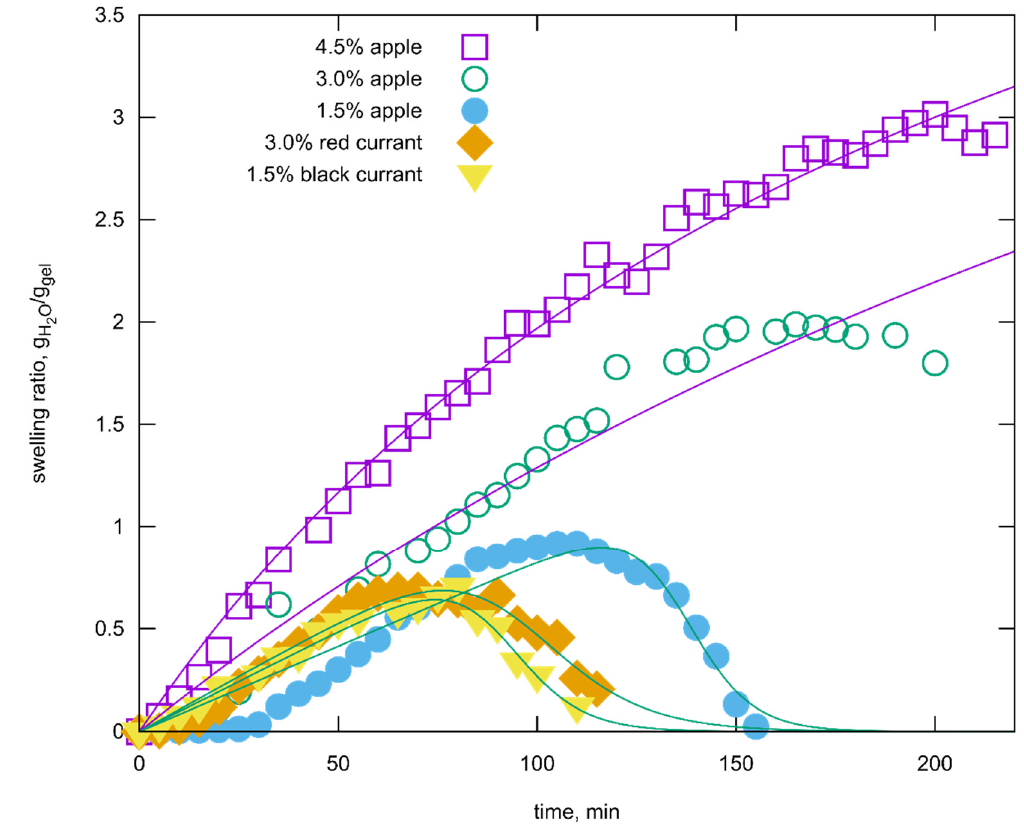
Figure 3. Swelling of gel beads in distilled water.